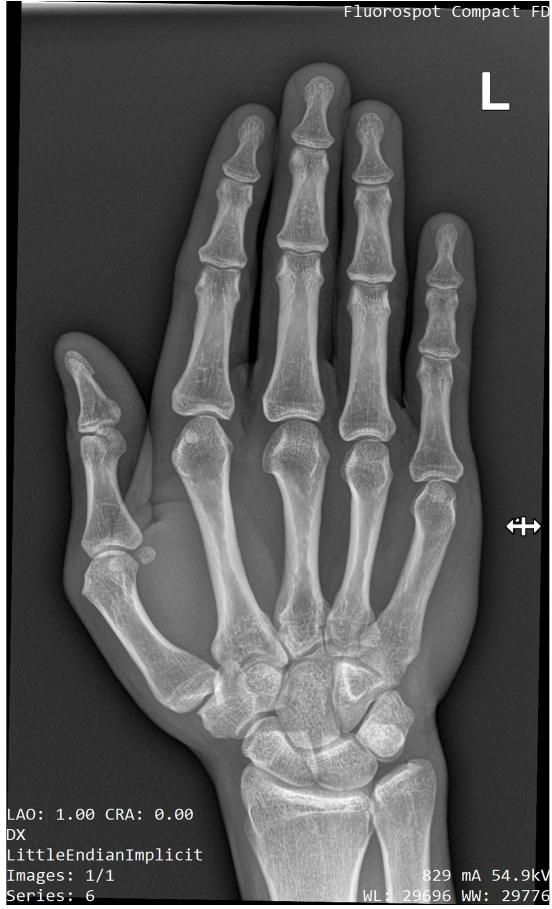
Figure 5. Radiographic image of the wrist joint in antero ‐ posterior view showing hypoplasia of the ulnar styloid process.